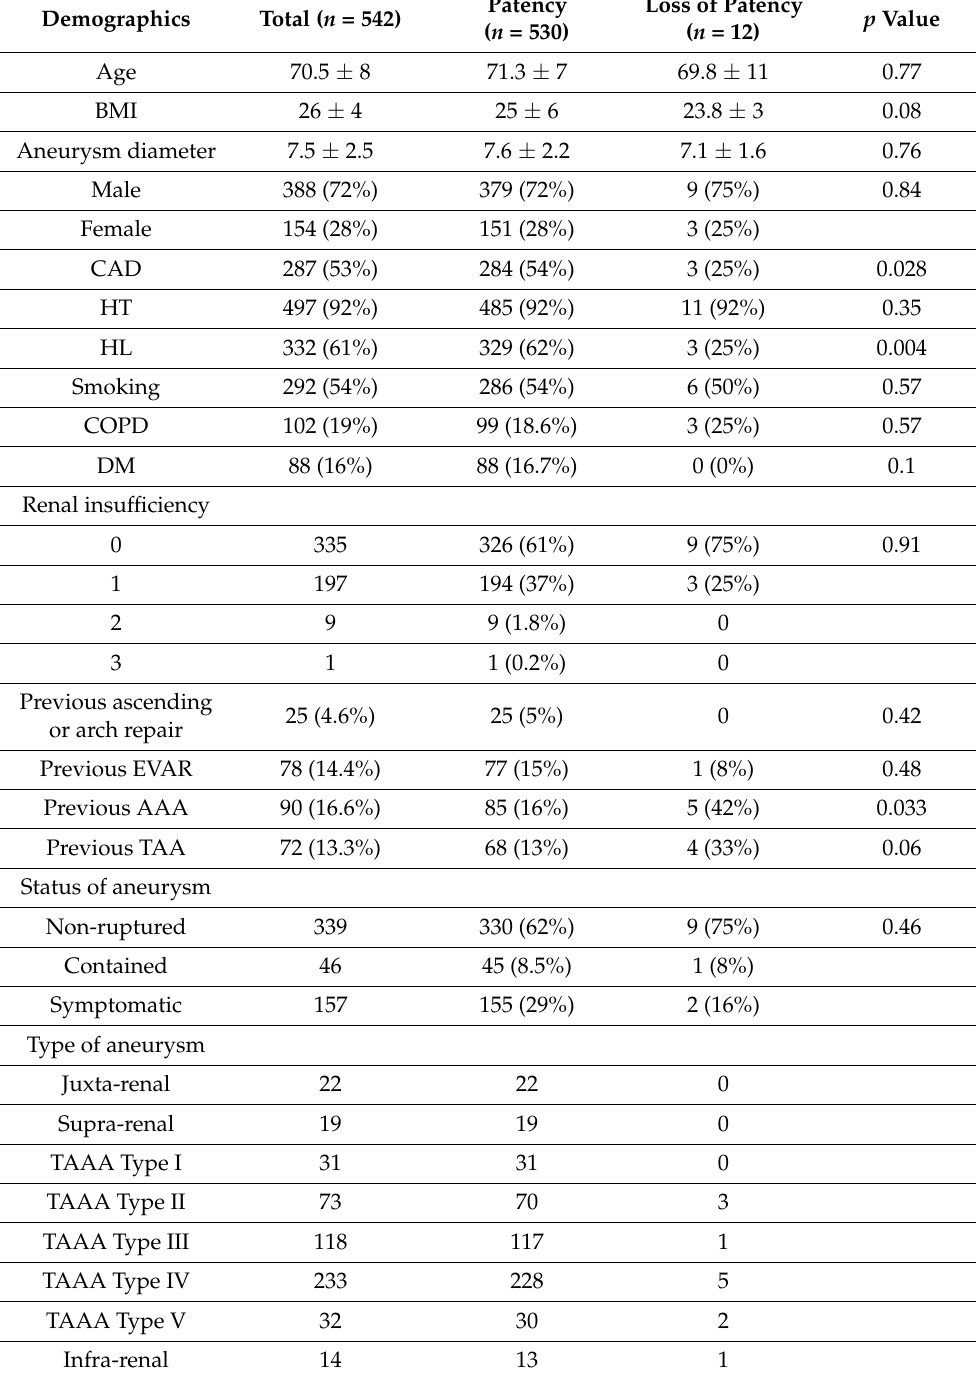
Table 1. Demographics, co-morbidities, past-surgical history, and clinical presentation. CAD: coro- nary artery disease; HT: hypertension; HL: hyperlipidemia; COPD: chronic obstructive pulmonary disease; DM: diabetes mellitus; EVAR: endovascular aneurysm repair; AAA: abdominal aortic aneurysm; TAA: thoracic aortic aneurysm; TAAA: thoraco-abdominal aortic